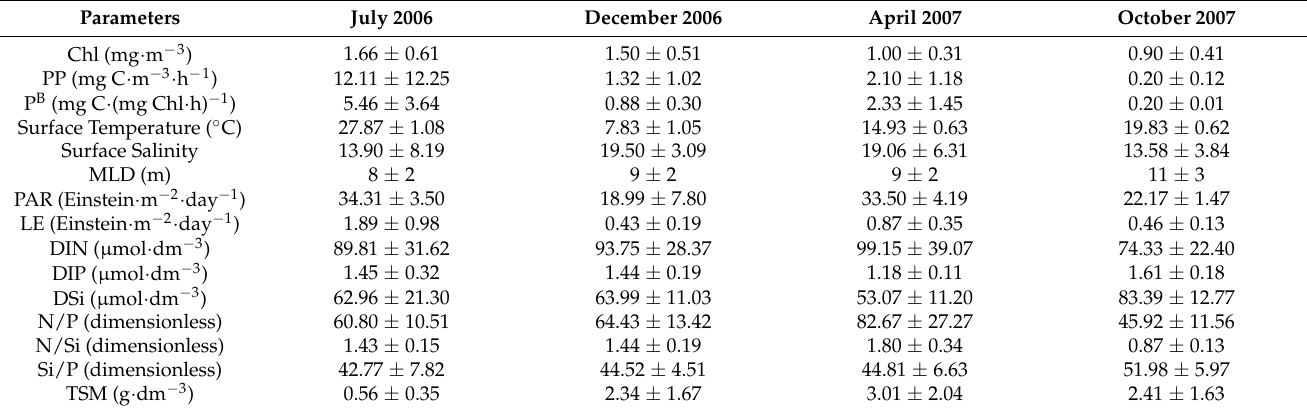
Table 1. Chl, PP, P B and environmental parameters recorded in the HZB in each cruise (mean ± SD).